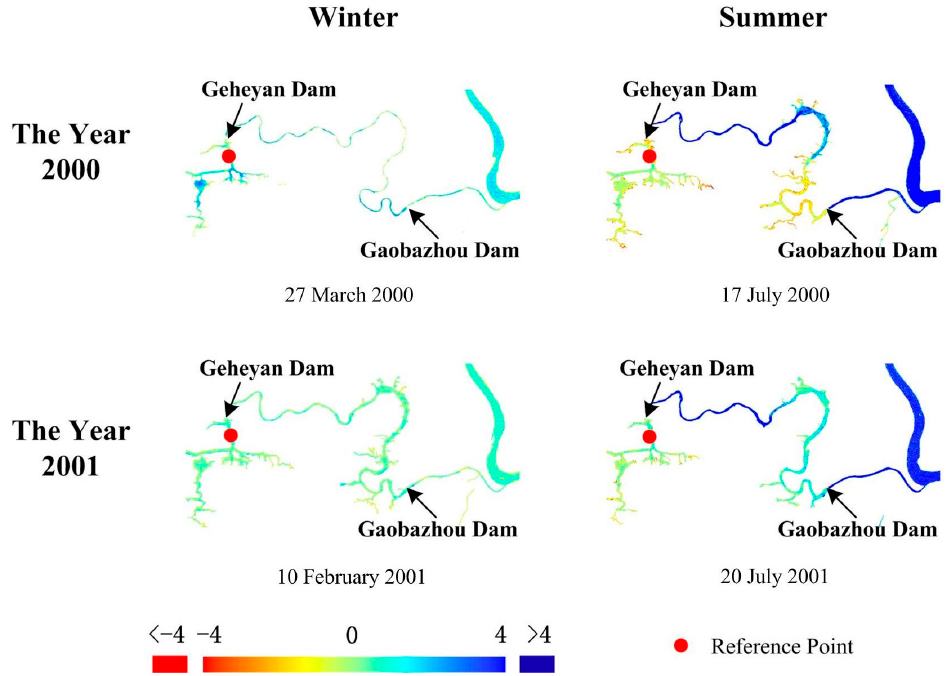
Figure 7. Relative water temperature variations derived using Landsat ETM+ imagery over four different dates.